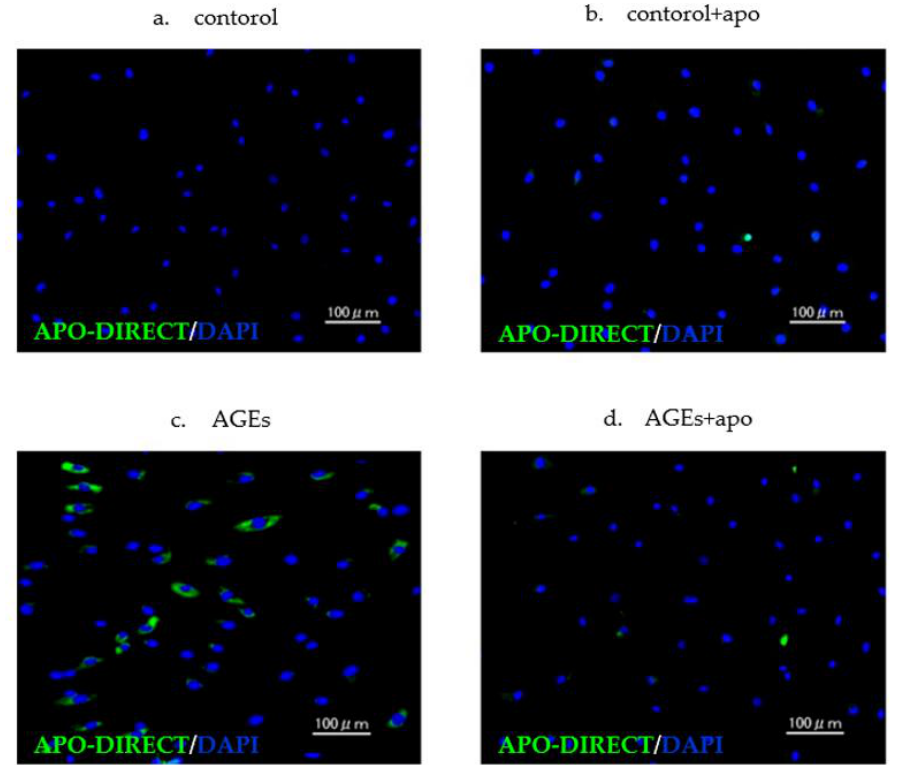
Figure 3. Immunofluorescence labeling depicting apoptotic (green) cells in each group. ( a , b ) There were few apoptotic cells in the control and control + apo groups. ( c , d ) There was apoptosis induction in AGEs and AGEs + apo groups. The amount of apoptotic cells in the AGEs + apo group was lower than that in the AGEs group.